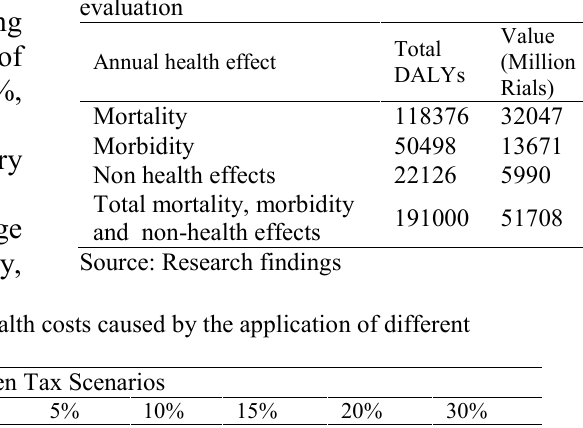
Table 2. Estimating health effects based on monetary